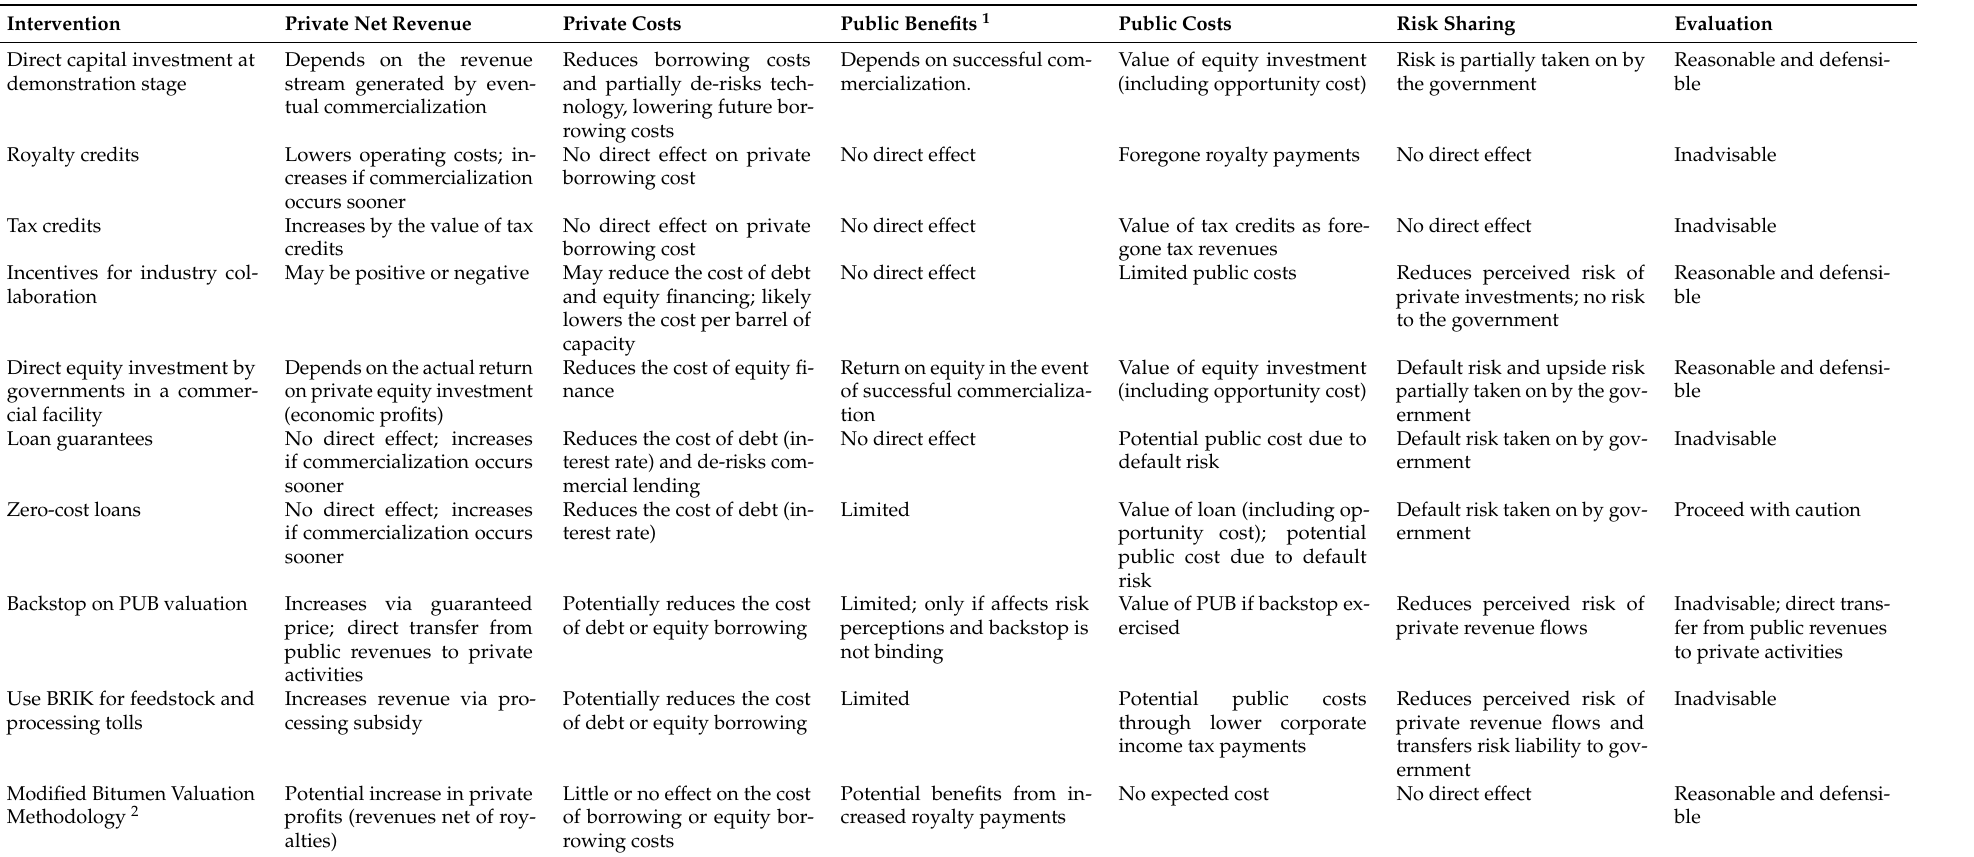
Table 2. Policy Interventions and Expected